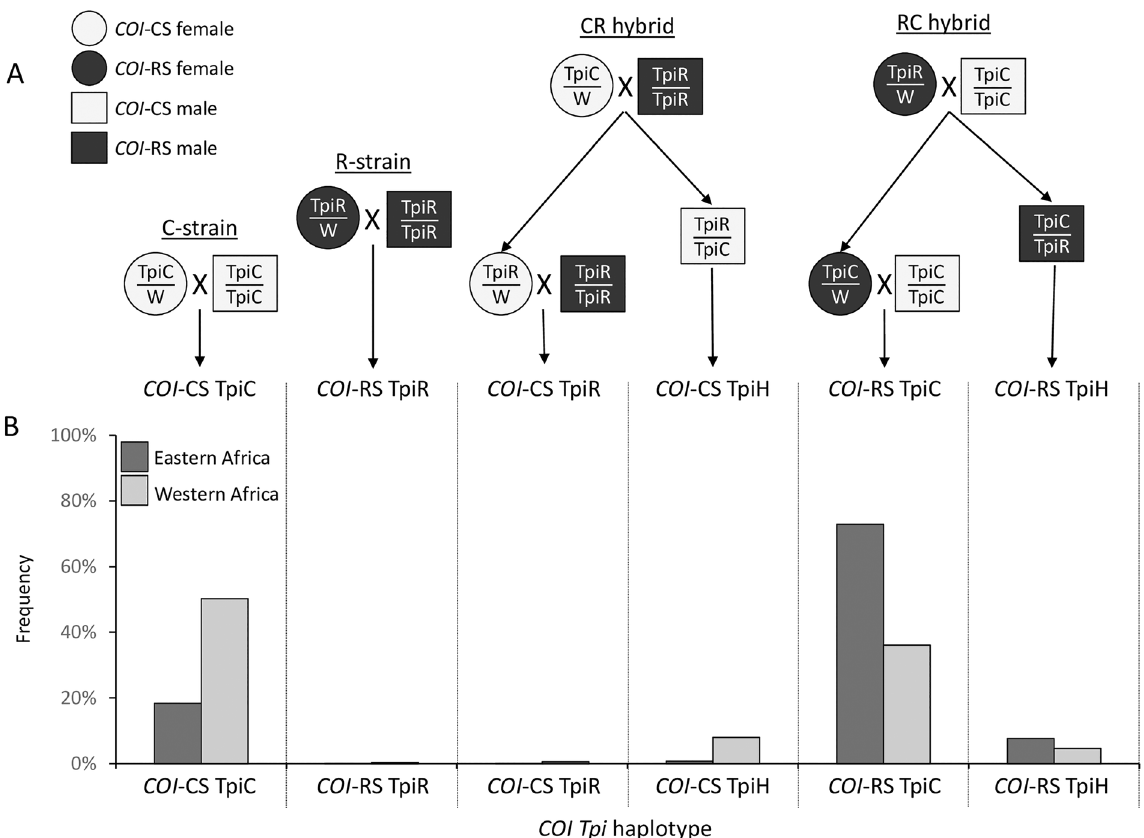
Figure 5. Description of origins and frequencies of the different observed COI Tpi haplotype configurations. ( A ) Describes crosses that can produce different COI Tpi combinations. The COI haplotype is maternally inherited and indicated by either a circle (female) or square (male), with shading differentiating COI -CS from COI -RS. The Z -linked Tpi gene is present in one copy in females ( Z/W ) and two copies in males ( Z/Z ) and undergoes sex-linked segregation. “CR hybrid” indicates cross between a C-strain female and R-strain male, while “RC hybrid” defines the reciprocal mating. ( B ) Describes the frequencies of the different COI Tpi configurations in western and eastern